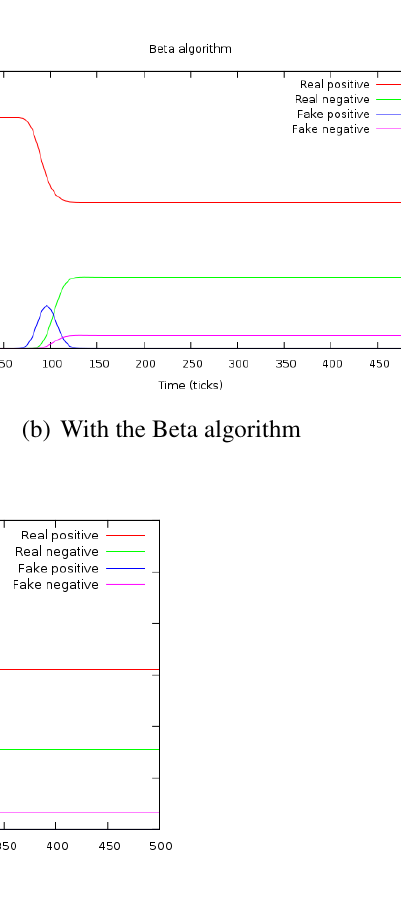
Figure 4. Evolution of the true/false positives/negatives for a sybil